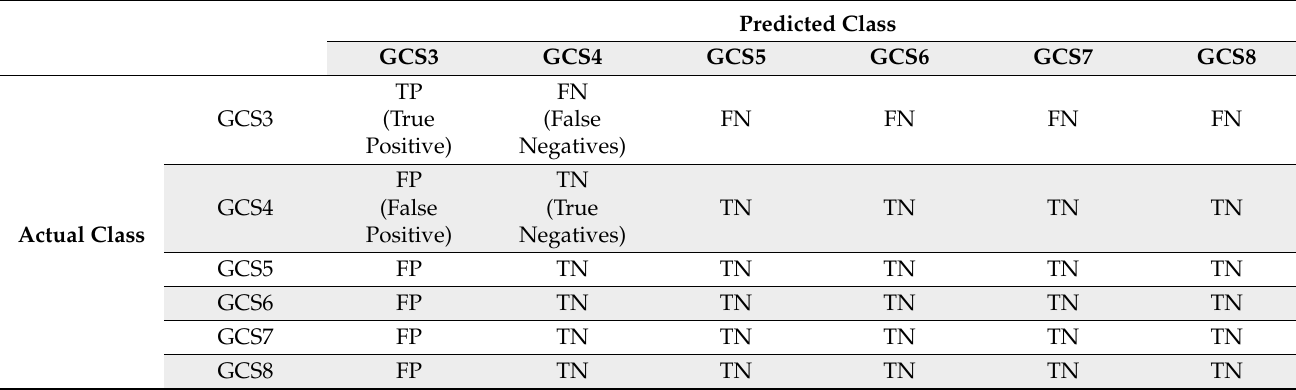
Table 3. Confusion matrix for GCS 3